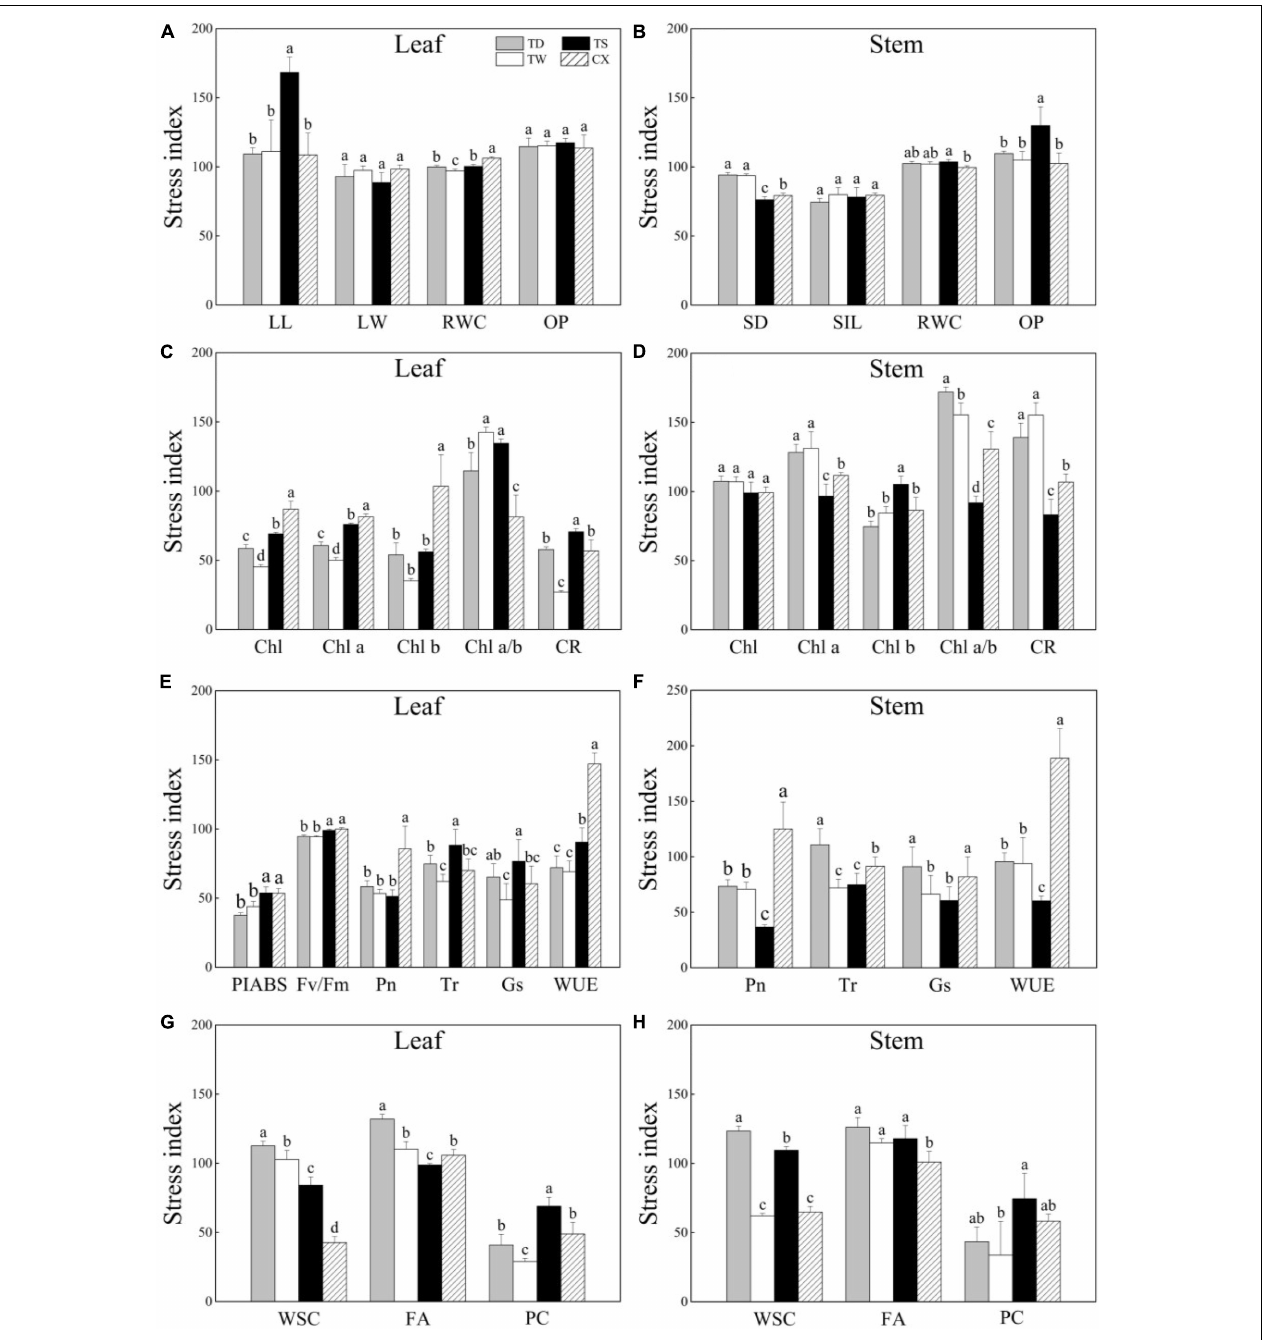
FIGURE 6 | (A–H) Effects of shade stress on stress index (SI) of four bermudagrass cultivars. Different letters above columns indicate significant differences ( p ≤ 0.05). Vertical bars indicate the ± SE of mean ( n =